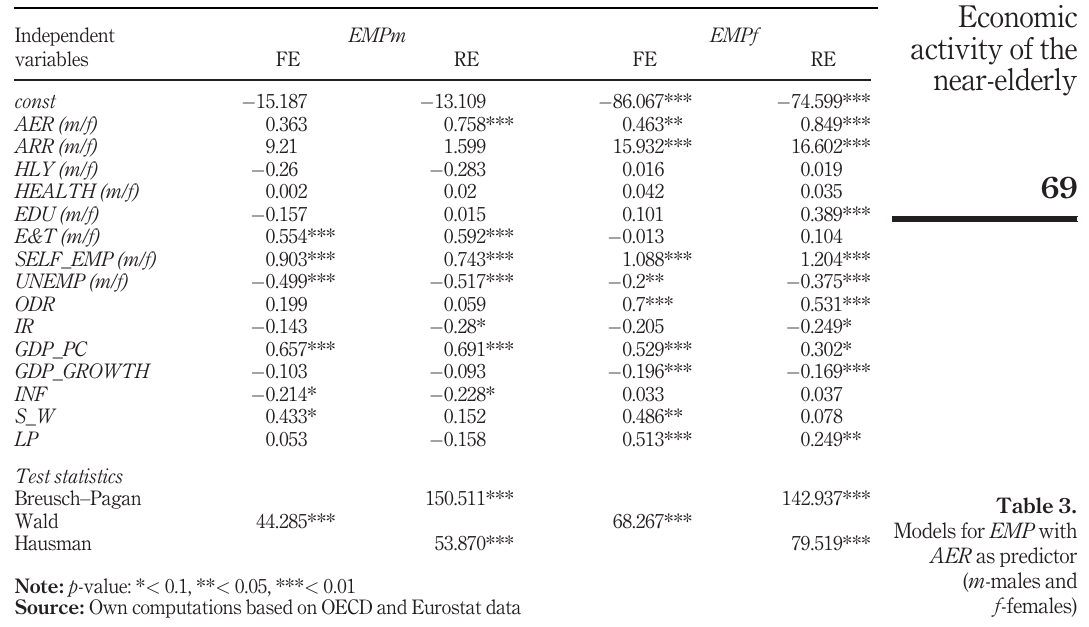
Table 3. Models for EMP